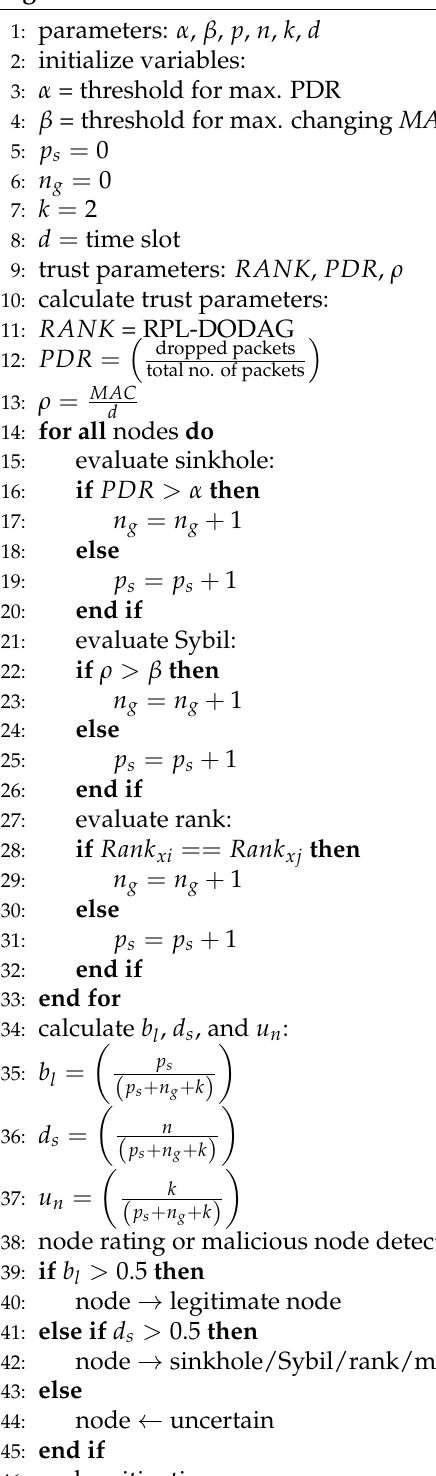
Algorithm 4 Malicious node detection and